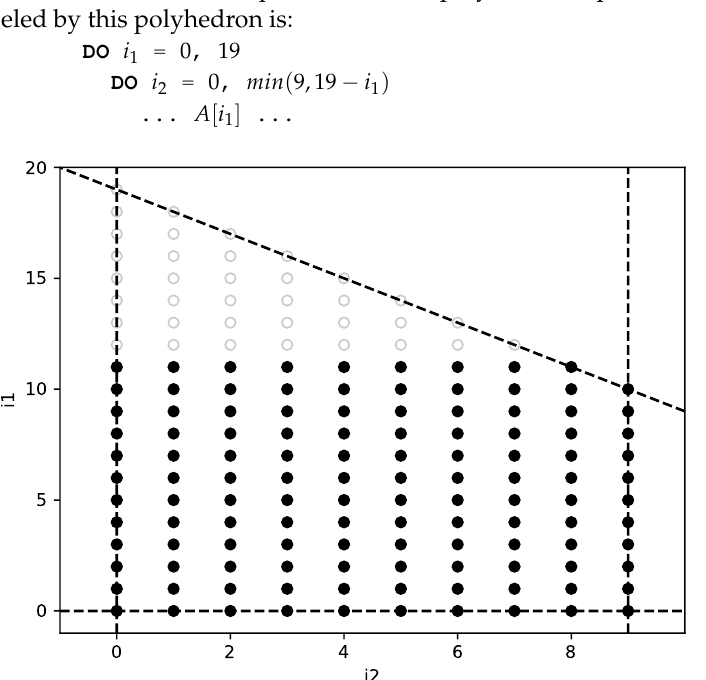
Figure 8. Example of iteration polyhedron with two different upper bounds hyperplanes associ- ated to i 2 . It corresponds to a loop using two different affine functions, f 1 and f 2 , combined as #» #» min ( f 1 ( ı ) , f 2 ( ı )) , in the upper bounds of the inner loop i 2 . The figure illustrates the state of the (cid:104) (cid:105) reconstruction upon reaching iteration vector , when it becomes apparent that a new upper 11 8 bounds face is needed to model the